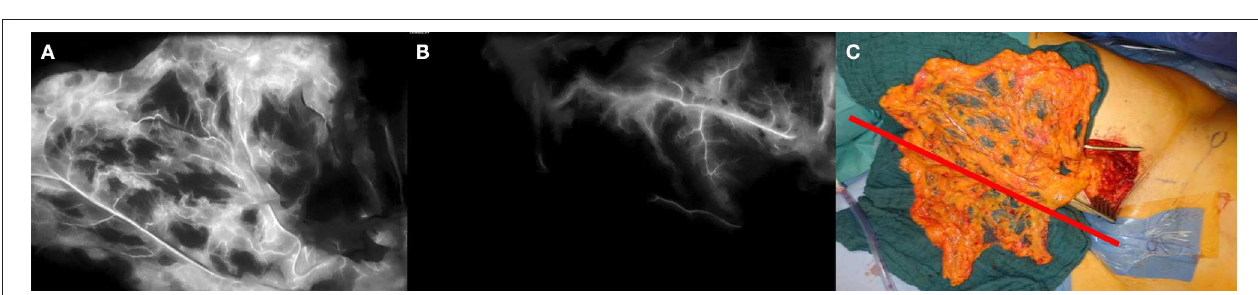
FIGURE 1 | Free anterior lateral thigh flap (ALT) for reconstruction of the dorsum of the left hand. (A) (left) ALT flap after harvesting at the left thigh. ICG angiography marking the perforasome perfused by the proximal perforator revealing a distinct perfusion border. (B) (middle left) Flap perfused via a proximal and distal perforator showing perfusion of adjacent perforasomes. (C) (middle right) ICG angiography color mode. (D) (right) ALT flap after inset at the left hand. Asterix within the flap marking the distal (right) and proximal (left) perforator.